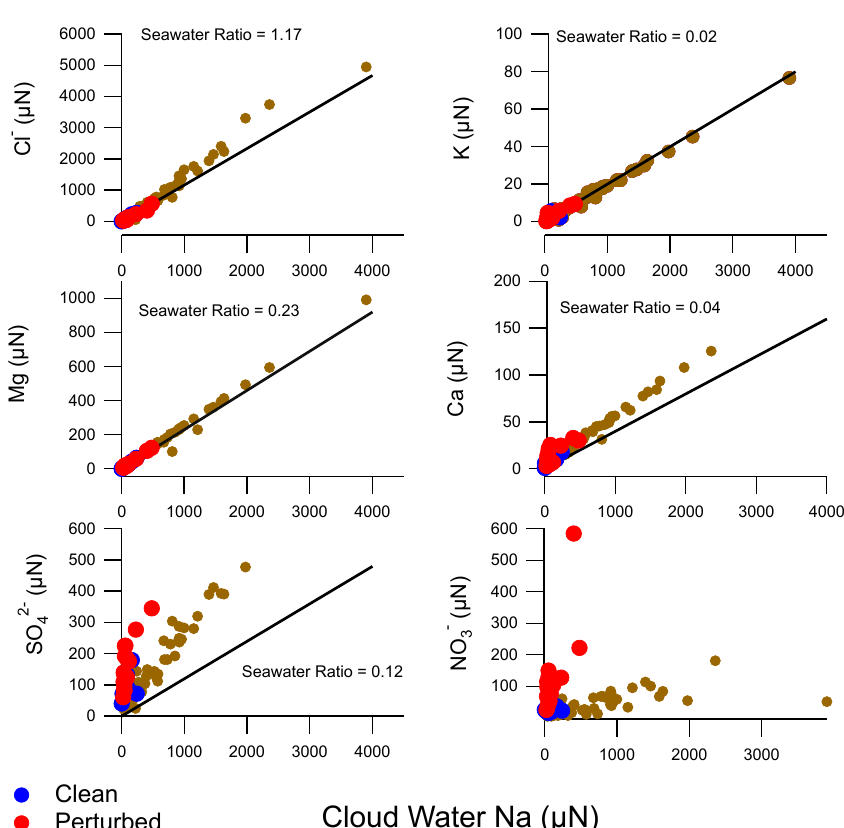
Fig. 5. Summary of major seawater species measured in marine cloud water. Data are presented analogously to those reported by Straub et al. (2007) and Benedict et al. (2012). In the present study, we assume that seawater species measured by ICP-MS (e.g., Na, K, Mg, Ca) reflect aqueous phase ions. The solid lines indicate the ion ratio typically observed in seawater. Each point represents a single cloud water measurement. Clean flights (RF 5–8) are colored in blue while perturbed flights (RF 14–18) are colored in red. The remainder of the flights are shown as brown